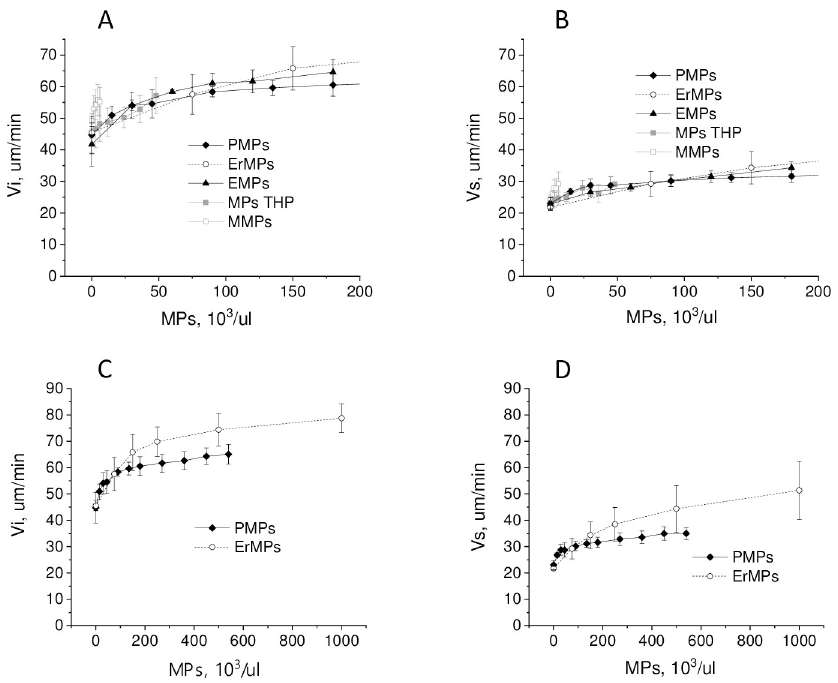
Fig 8. Influence of MPs of different origin on coagulation propagation. Mean ± sd dependence of the initial (A) and stationary (B) clot growth rates on platelet (PMPs) (n = 10), erythrocyte (ErMPs) (n = 7), endothelial (EMPs) (n = 5), THP monocyte culture (THP MPs) (n = 6) and monocyte (MMPs) (n = 5) microparticles concentrations. (C), (D) The same dependences on a smaller scale.